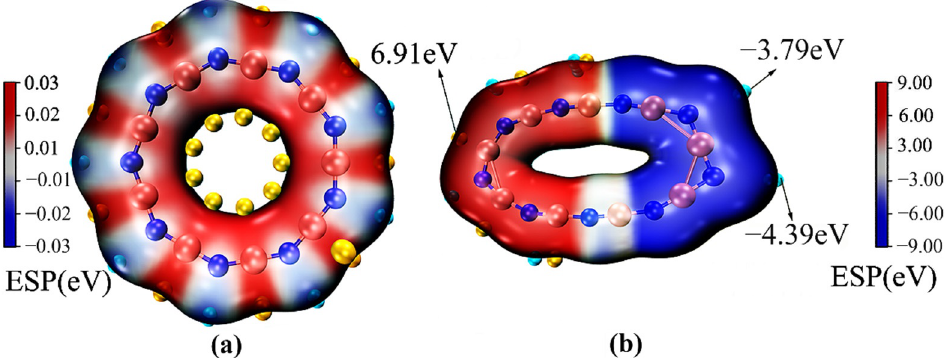
Figure 4. Distribution of the electric potential on the van der Waals surface of the B 9 N 9 molecule; ( a ) depicts the ESP in the absence of an EEF; ( b ) depicts the ESP at EEF = 0.0365 a.u.